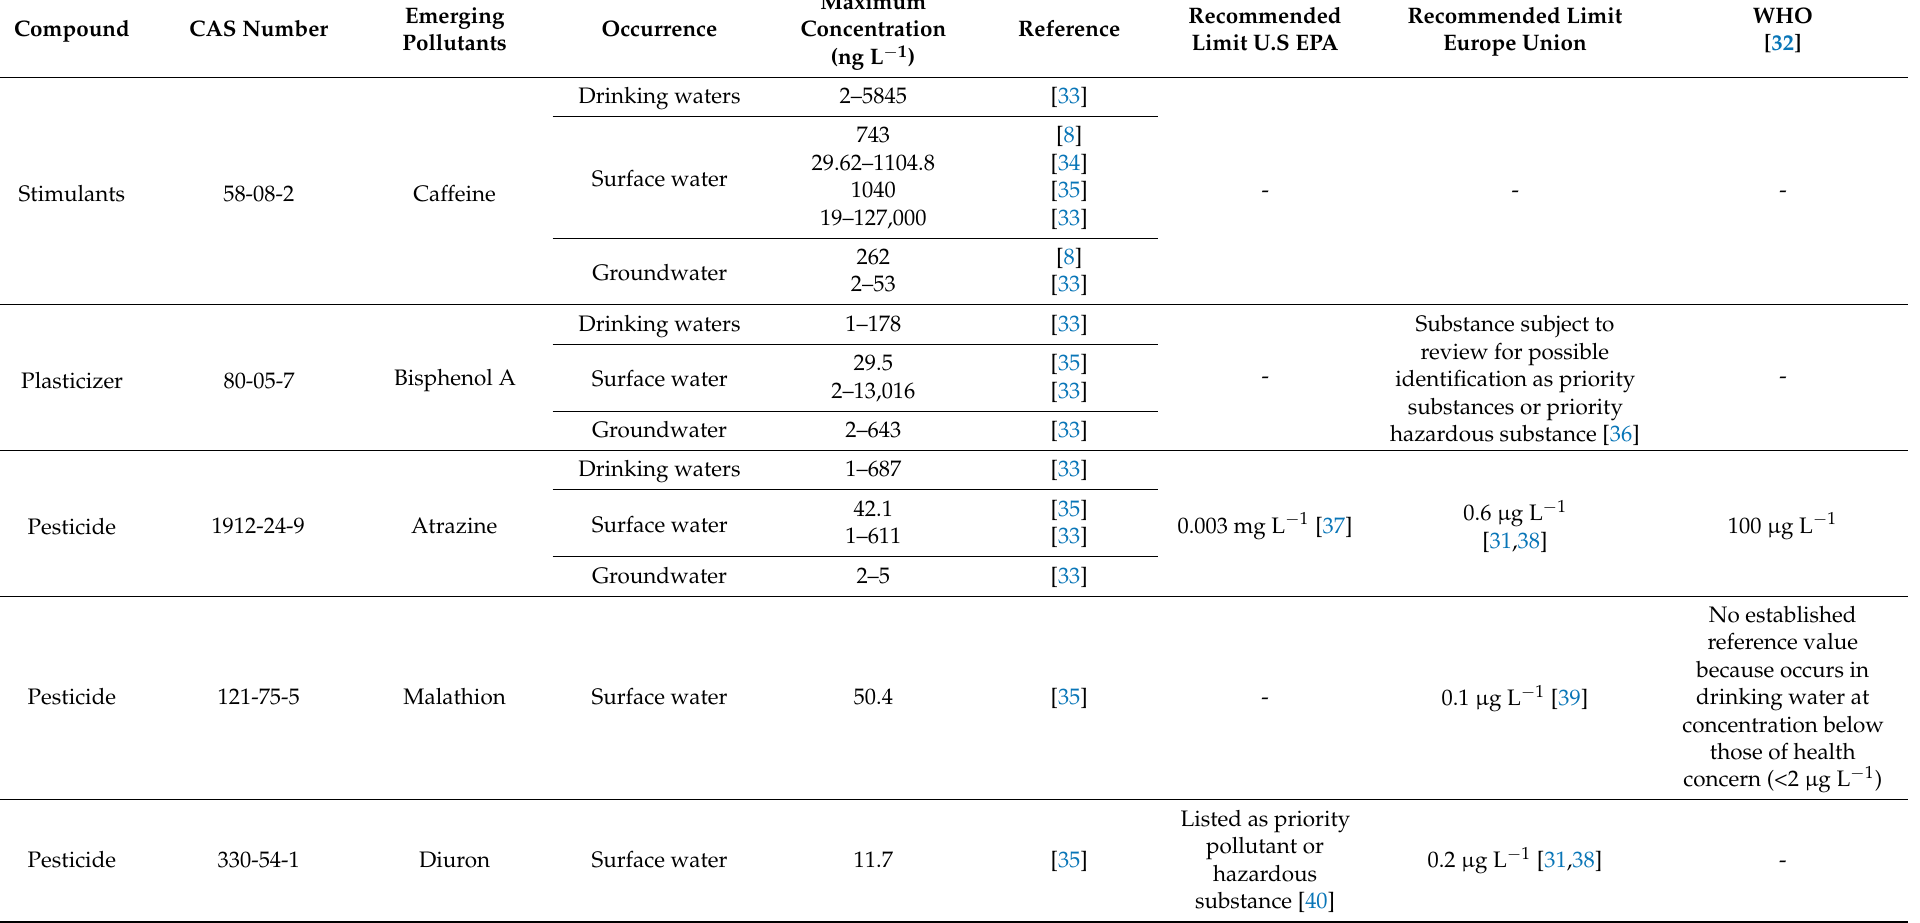
Table 1. Reference values of concentration of priority pollutants and admissible concentrations in water